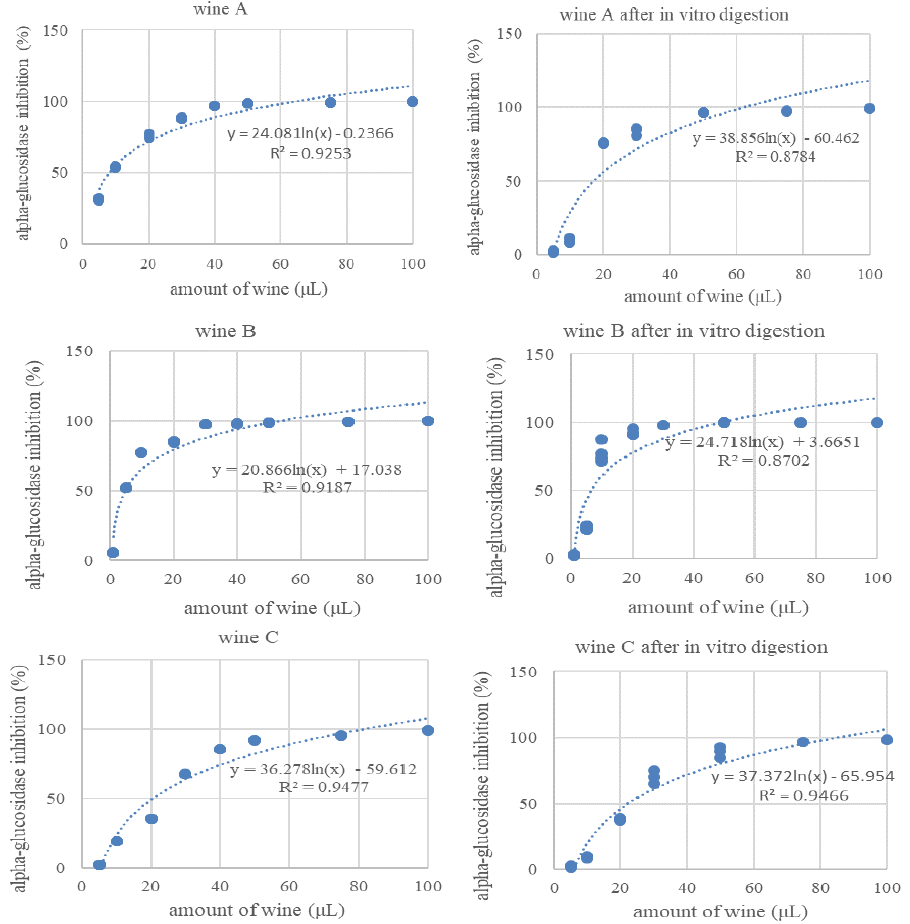
Figure 6. Inhibitory effect of the tested cherry wines against alpha-glucosidase activity before and after in vitro digestion.